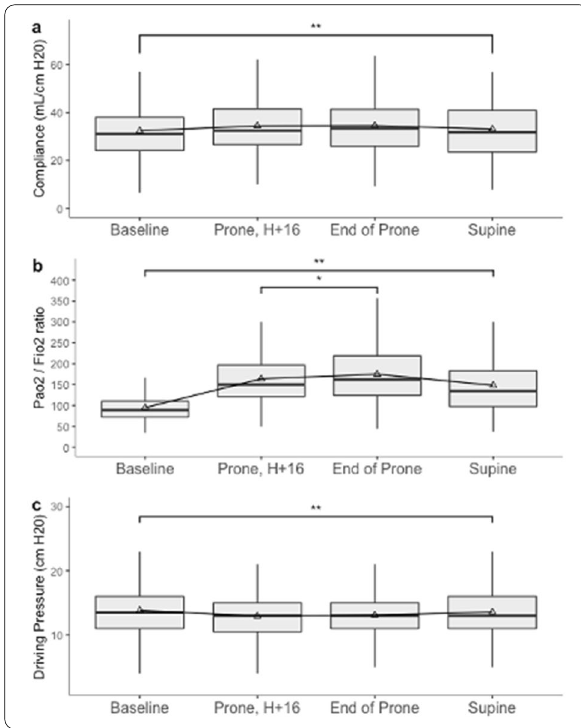
Figure 1 Physiological parameter’s changes during proning